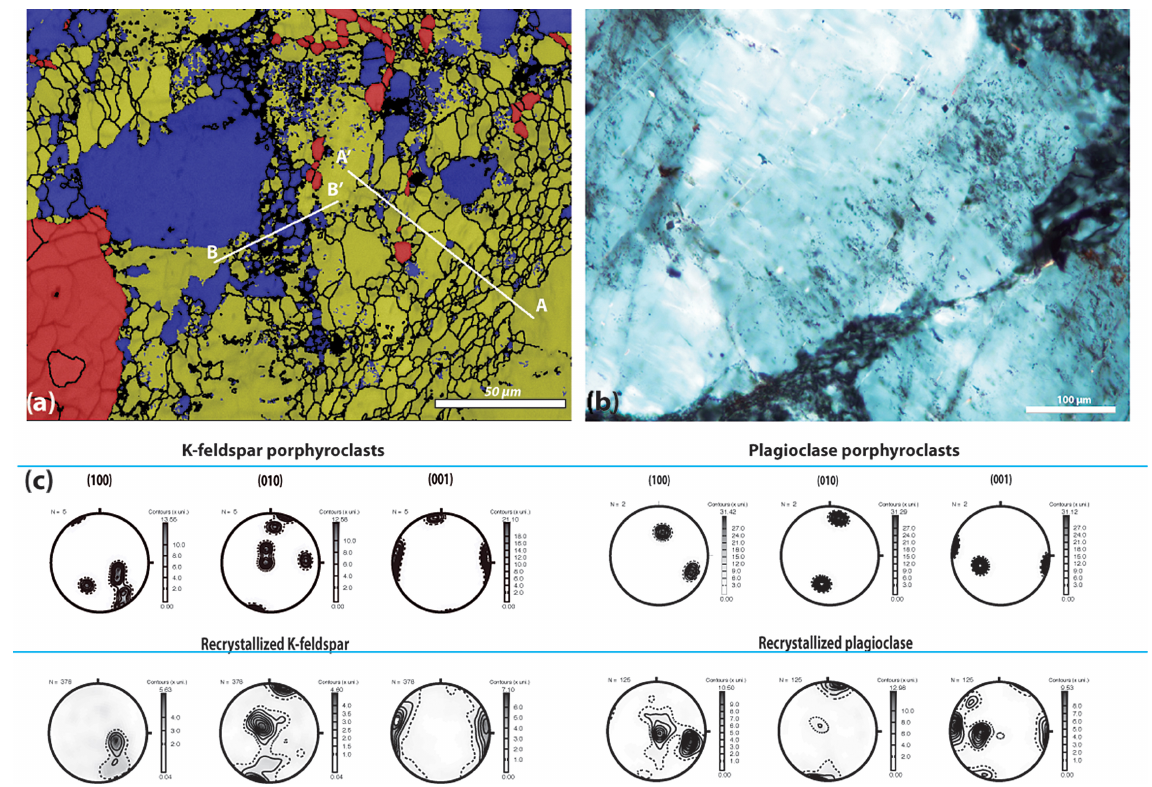
Figure 10. (a) EBSD phase map of an intracrystalline fracture in feldspar porphyroclast (red is quartz; blue is plagioclase; yellow is K- feldspar). Misorientation profiles A–A’ and B–B’ are shown in Fig. 11. (b) Optical micrograph of a fracture and its filling; (c) pole figures for feldspar as porphyroclasts and as recrystallized grains. See text for